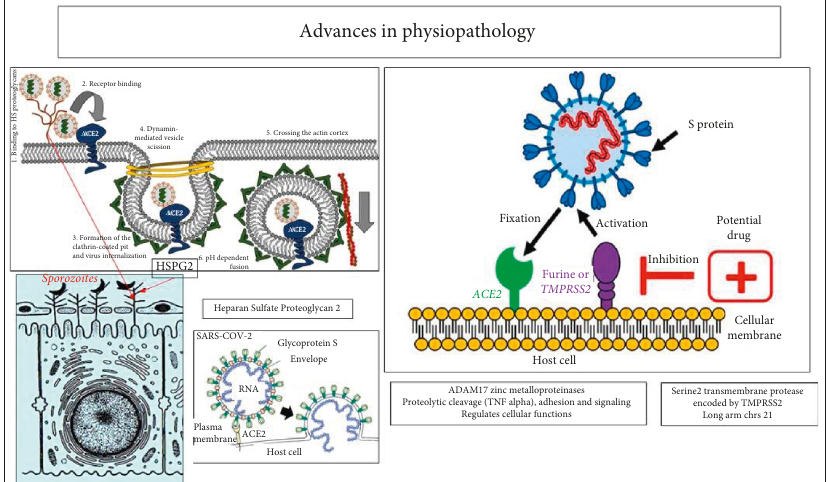
Figure 5: Comparison of the actions of SARS-CoV-2 and Pf sporozoites on HSPG2 (Source https://wikipedia.org and